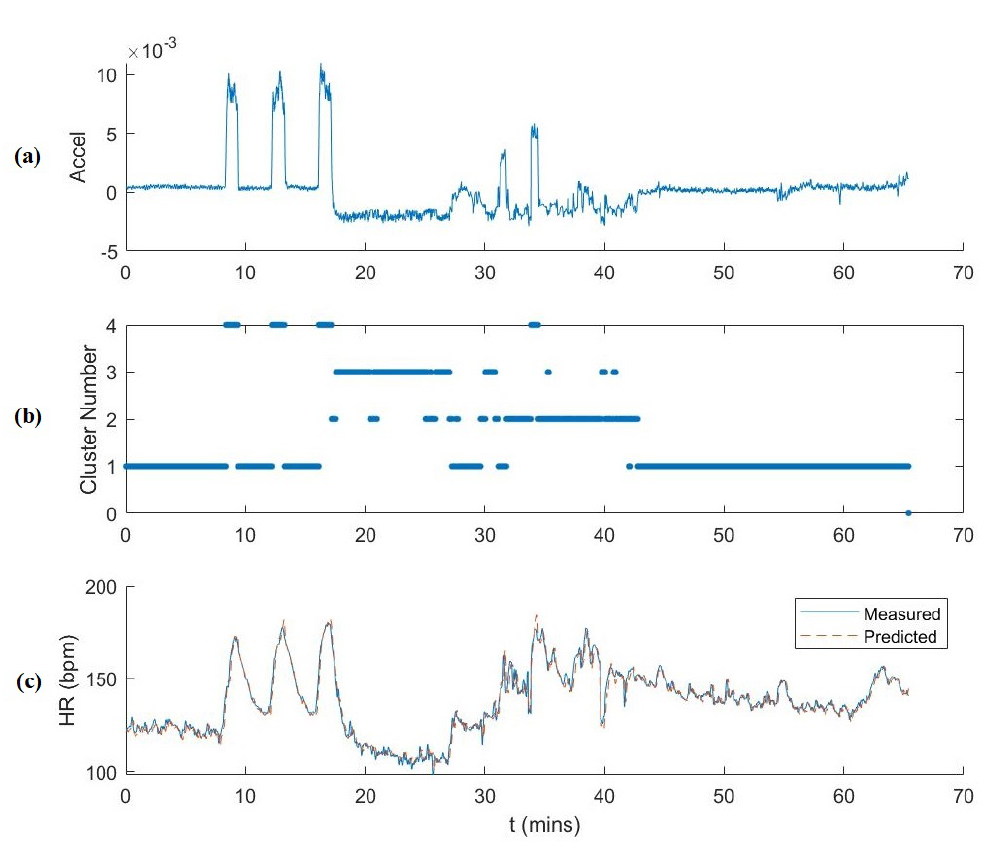
Figure 7. Illustration of the prediction process ( δ h = 30 s). From top to bottom: ( a ) the first dimension of the reduced accelerometer data features used for clustering over time; ( b ) activity cluster number over time; and ( c ) measured and predicted HR over